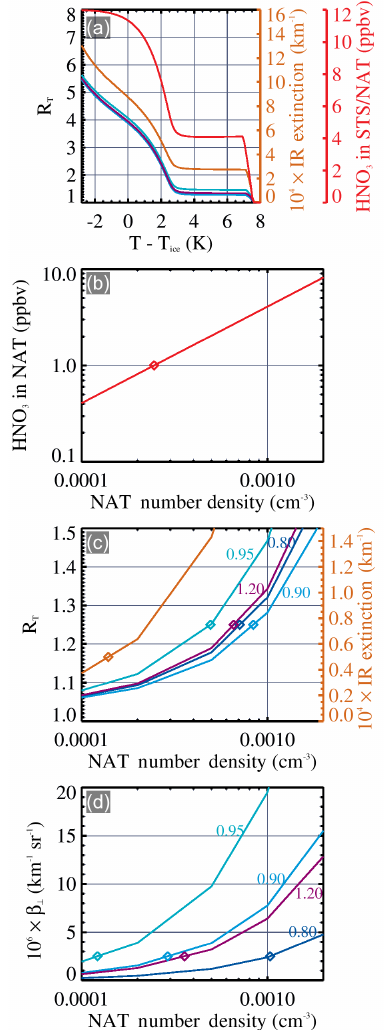
Figure 5. (a) Temperature variation relative to the frost point of the uptake of HNO 3 in an STS/NAT mixture (red) for a NAT num- ber density of 0.001cm − 3 and an effective radius of 6.5µm, the calculated lidar backscatter ratio for four different particle shape aspect ratios (purple–blue), and the 12µm infrared extinction (or- ange). (b) Condensed HNO 3 in NAT (red line) at T − T ICE = 5K as a function of NAT number density. (c) NAT detection limits for li- dar total backscatter ratio (blue–purple diamonds) and infrared limb extinction (orange diamond) and correspondence to the NAT num- ber density. (d) As (c) , except for the lidar perpendicular backscatter coefficient